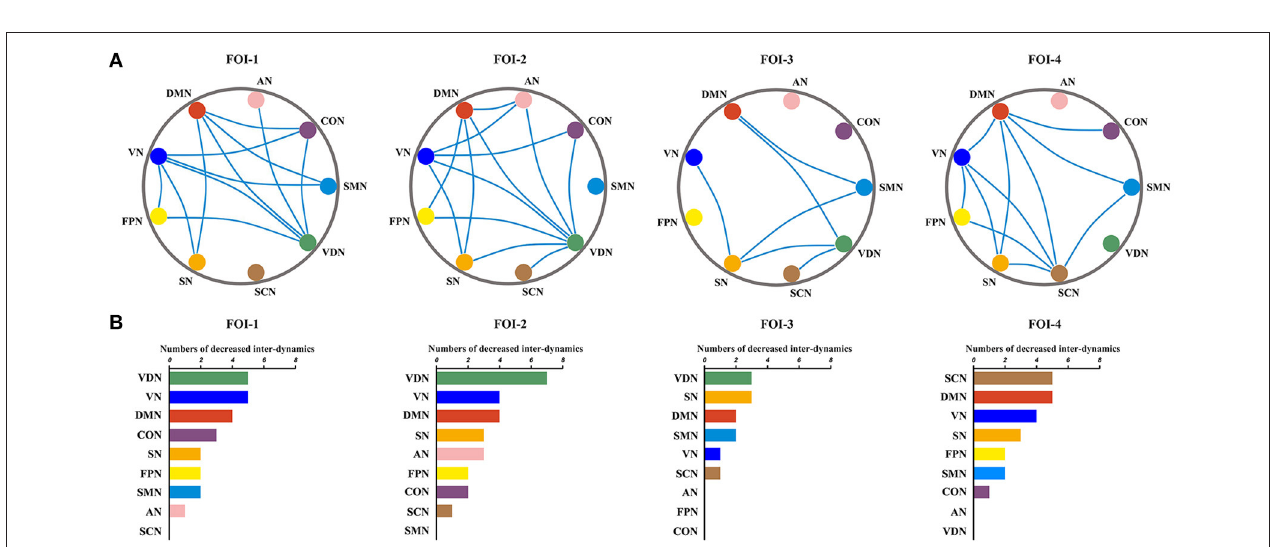
FIGURE 5 | Fluctuations of inter-RSN dynamics over frequency bands. Significant between-group differences of inter-RSN dynamics (A) and the corresponding difference numbers of individual RSNs to the rest of RSNs (B) in each FOI. The blue lines represent significantly decreased inter-RSN dynamics between two pairs of RSNs in JME. Two sample t- test, significant level was set at P < 0.05, with Bonferroni corrected.